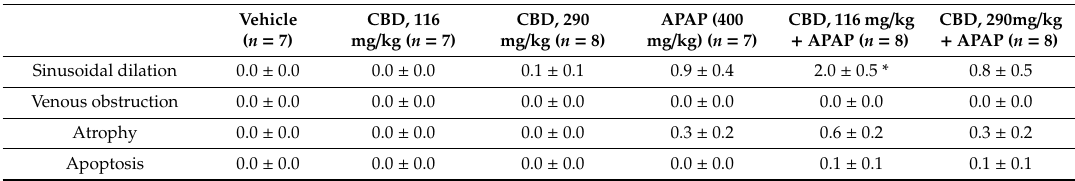
Figure 1. Co-administration of cannabidiol-rich cannabis extract (CRCE) and APAP results in sinusoid obstructive syndrome-like histomorphological alterations in the livers of aged female CD-1 mice. H&E stained liver sections from ( A ) vehicle-gavaged mice (sesame oil), ( B ) 116 mg / kg CBD, ( C ) 290 mg / kg CBD, ( D ) APAP (400 mg / kg), ( E ) 116 mg / kg CBD + APAP, ( F ) 290 mg / kg CBD + APAP. Black brackets indicate areas of clear cell changes ( D ), yellow brackets ( E ) and arrows ( F ) indicate areas of sinusoidal dilation with vascular congestion, and blue arrows ( E ) indicate areas of hepatic plate Table 1. Histopathological evaluation of mouse livers using a modified Rubbia-Brandt sinusoid obstructive syndrome (SOS)-I scoring system.